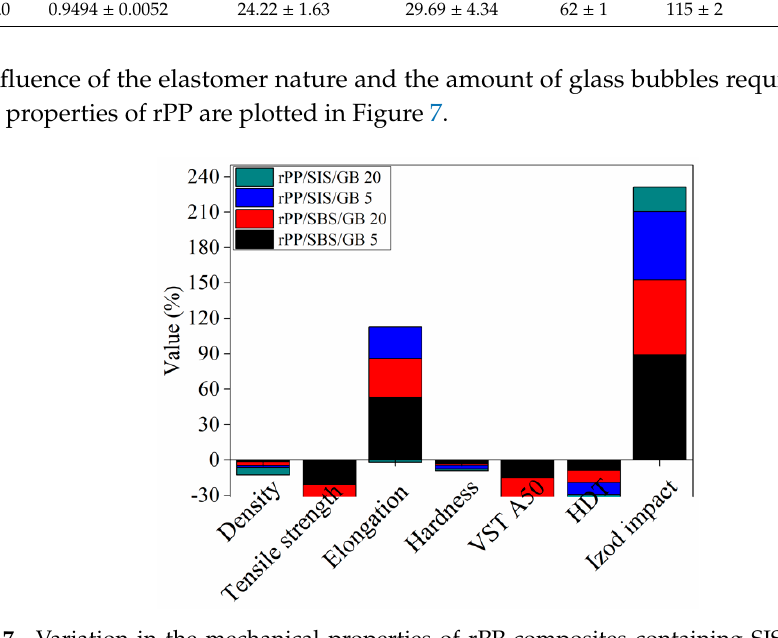
Figure 7. Variation in the mechanical properties of rPP composites containing SIS, SBS, and GB versus rPP.